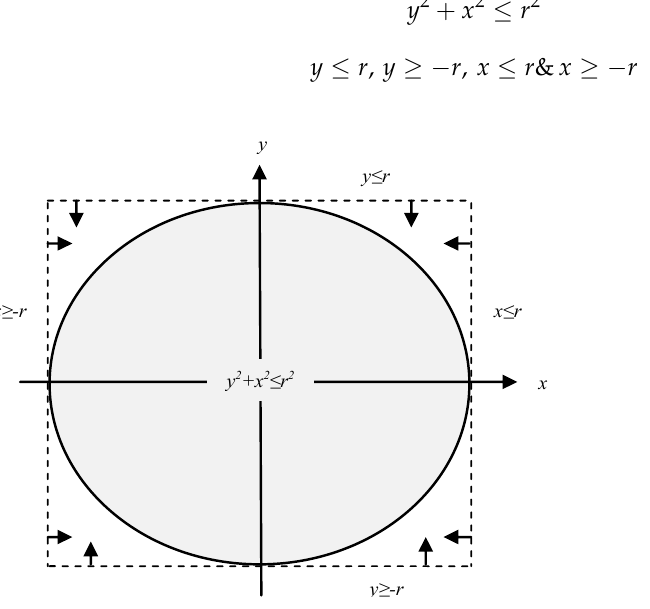
Figure 2. The linearization of the circular plane.